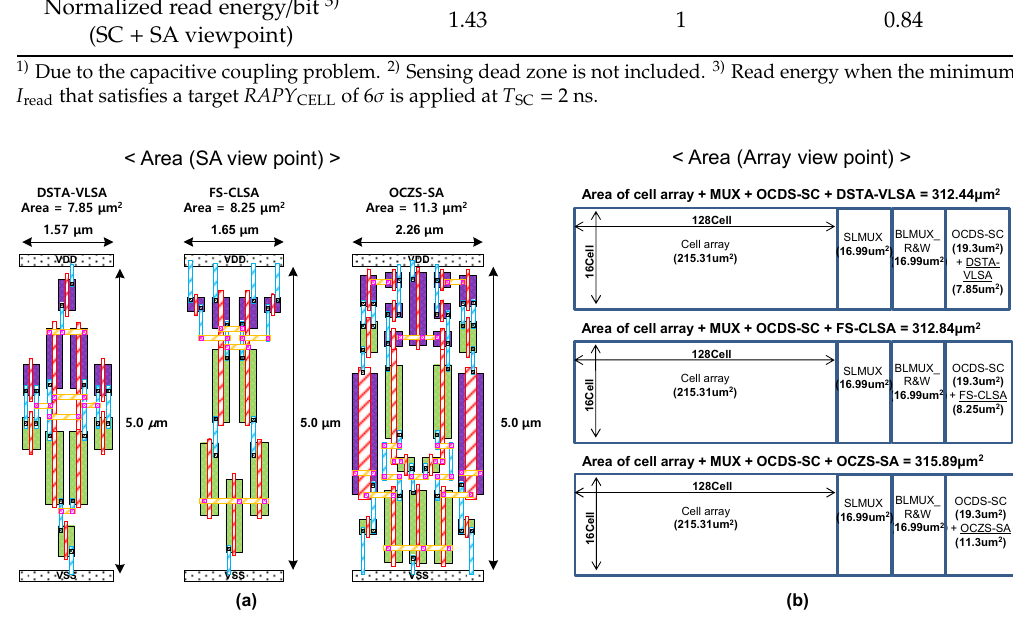
Figure 12. Minimum I read of the OCDS-SC that satisfies a target RAPY CELL of 6 σ according to T SC at σ SA_OS values of 33.8 mV, 20 mV, and 9.62 mV. Figure 13. Normalized read energy per bit according to T SC in cases of OCDS-SC + DSTA-VLSA, OCDS-SC + FS-CLSA, and OCDS-SC + OCZS-SA.